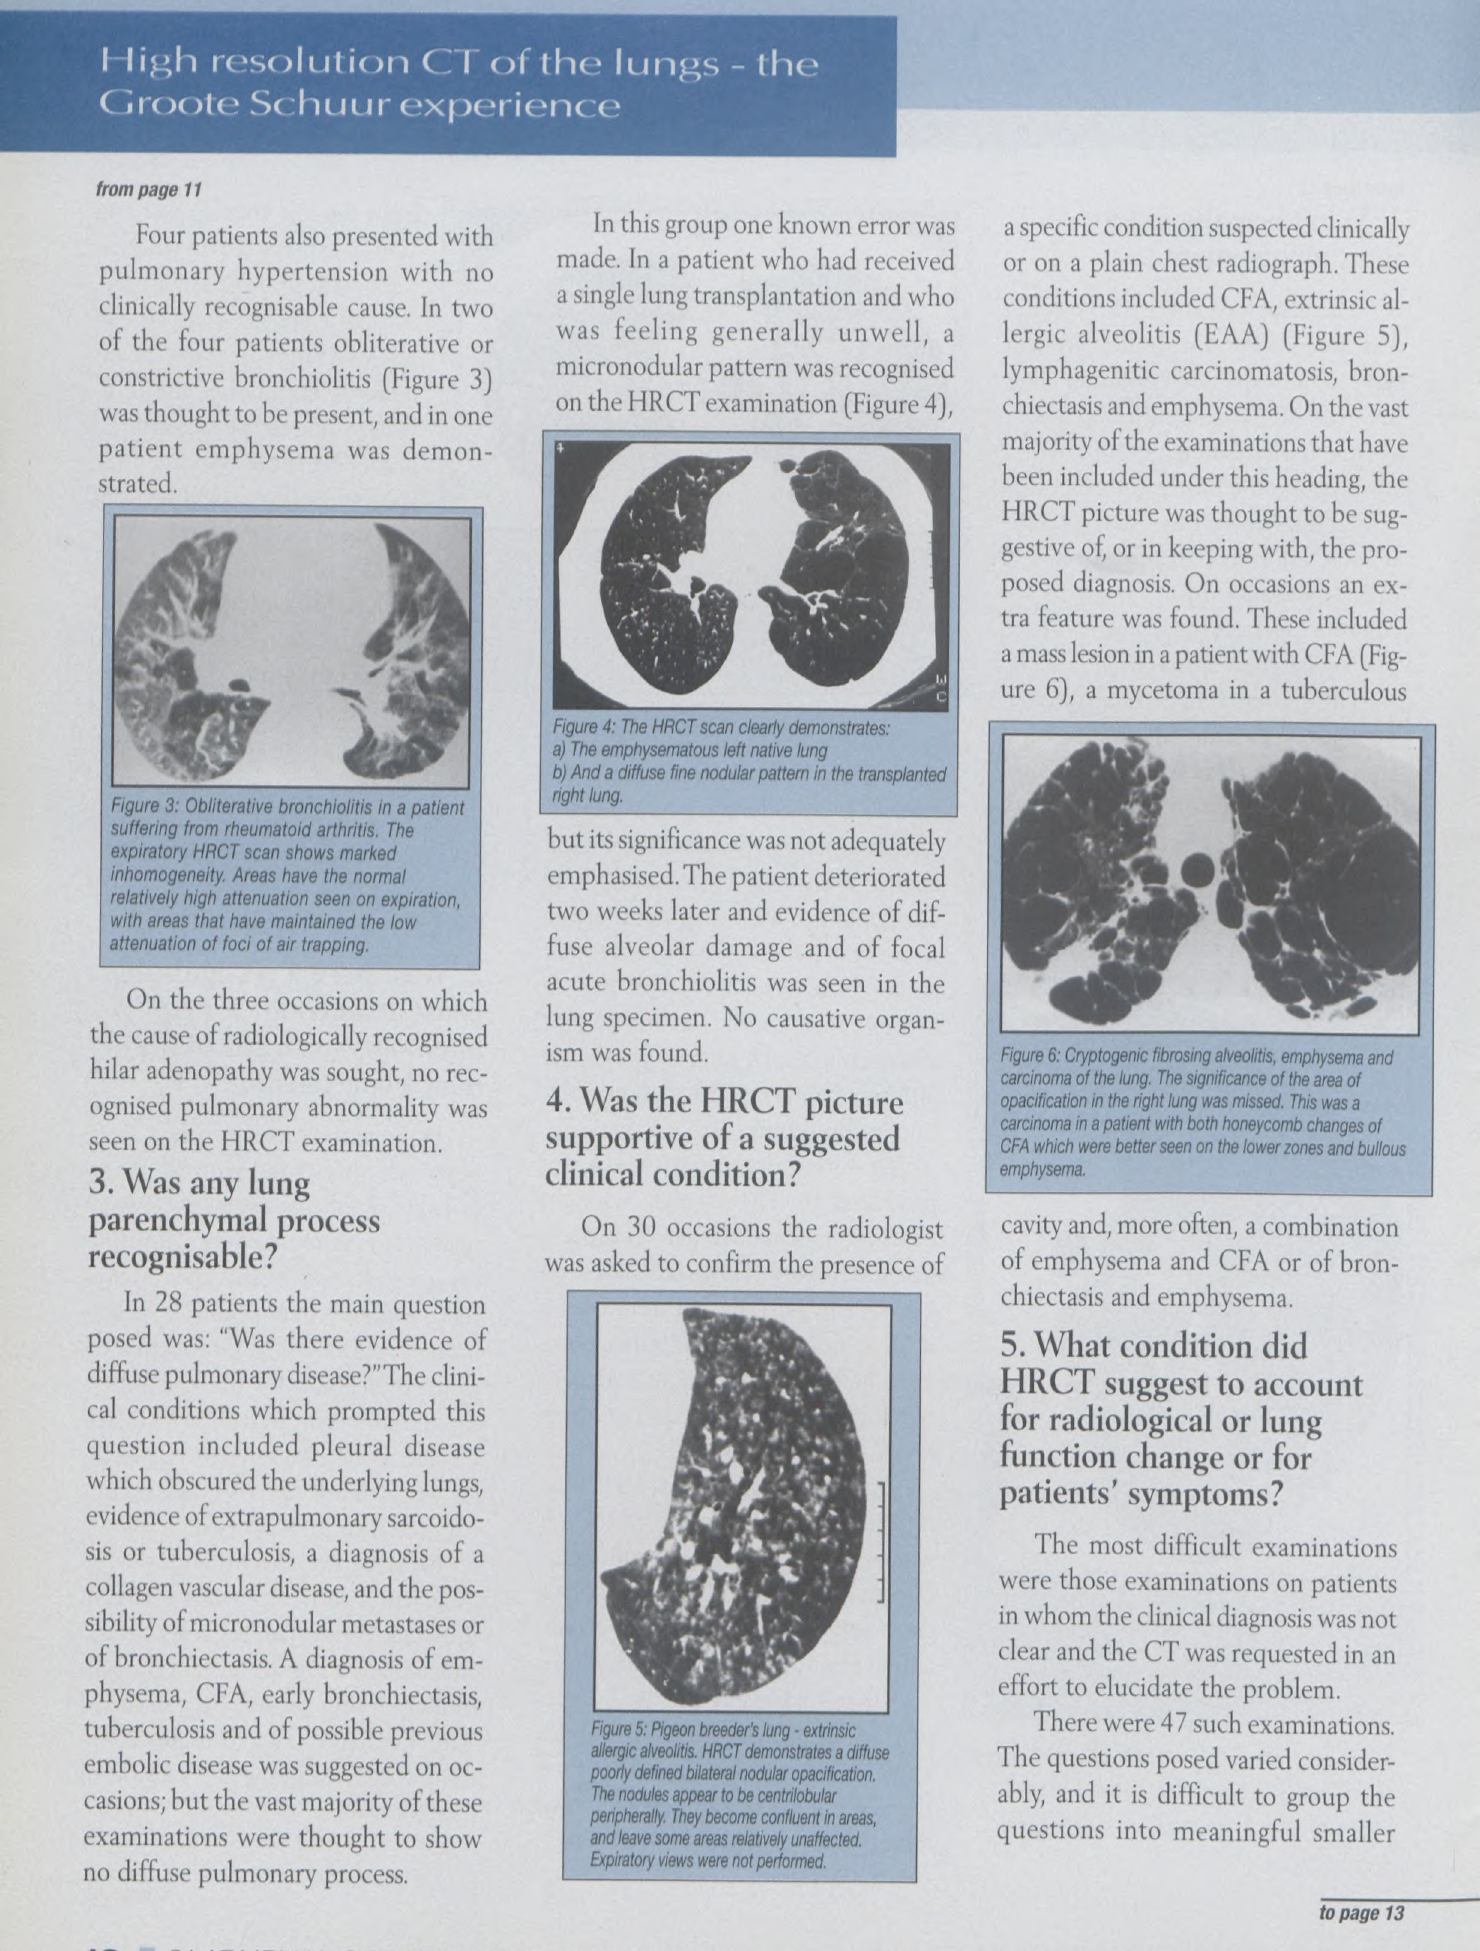
Figure 5: Pigeonbreeder'slung- extrinsic allergicalveo/itis.HRCTdemonstrates a diffuse poorly definedbilateralnodularopacification. Thenodulesappearto be centrilobular peripherally.Theybecome confluent inareas, andleavesomeareasrelativelyunaffected. Expiratoryviewswerenotperformed.